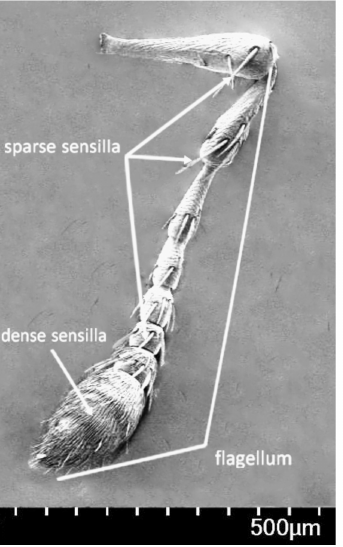
Figure 5. Antenna of Rhynchaenus maculosus adult.